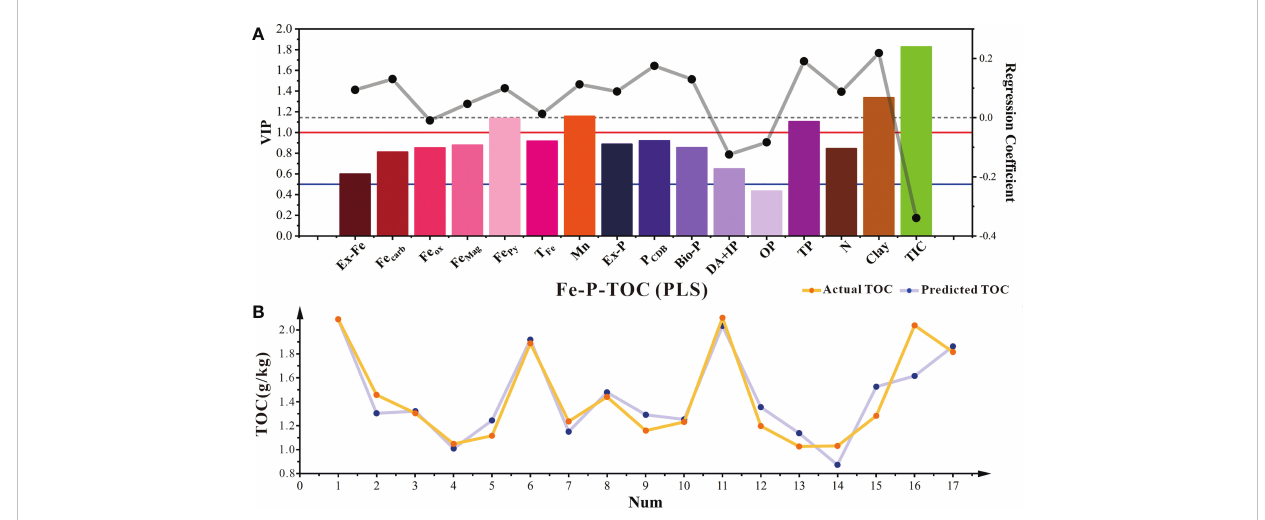
FIGURE 8 PLS model of TOC with different in fl uencing factors in sediments (A) . The histogram showed the variable importance of projection (VIP) for each predictive variable; The dot plot showed the regression coef fi cients of each in fl uence factor. The red solid line, blue solid line, and black dashed line represented different thresholds (VIP=1, VIP=0.5, and RC=0). And the comparison between the predicted results of the PLS model and the actual results (B)